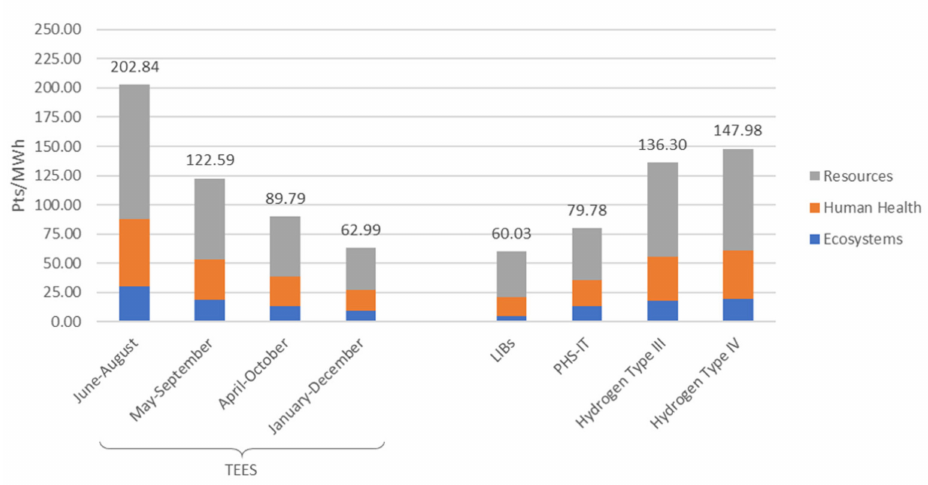
Figure 4. Single score environmental impacts of the analyzed